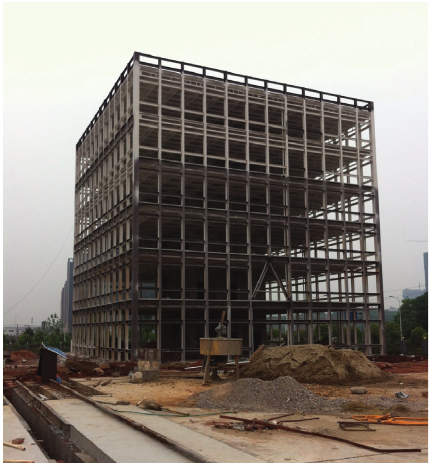
Figure 1: Engineering practice of SGFCG.